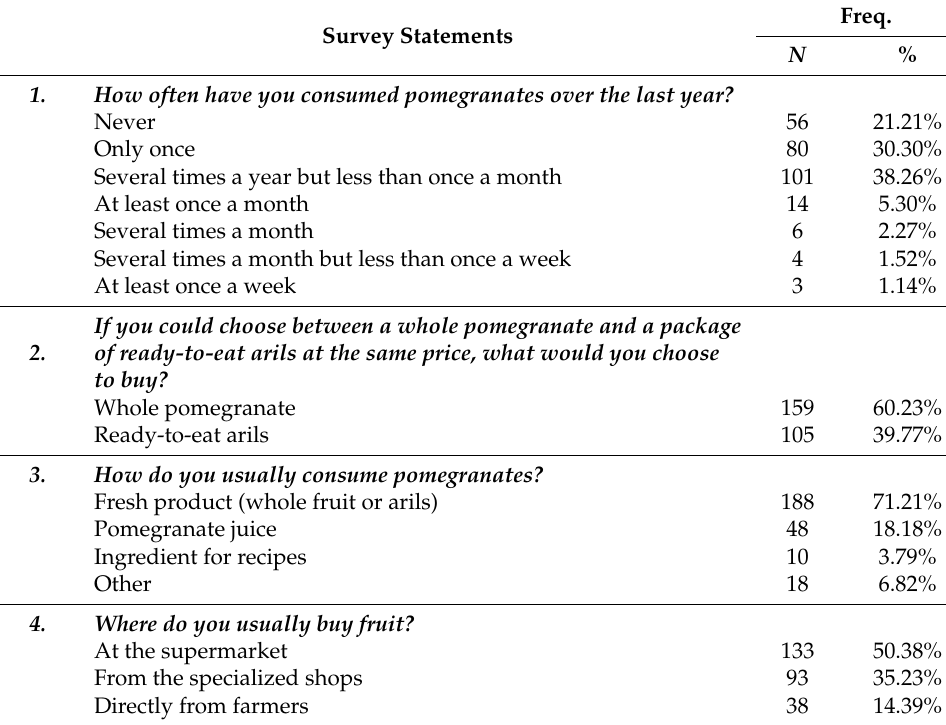
Table 4. Descriptions of sample consumption